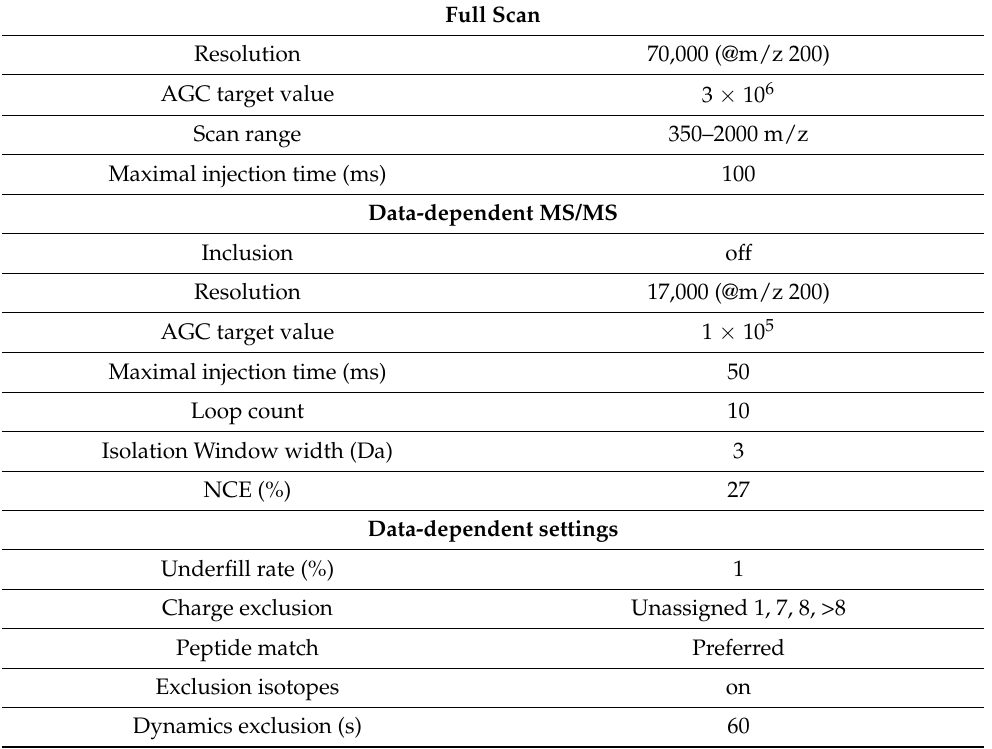
Table A1. Mass spectrometry data acquisition parameters.